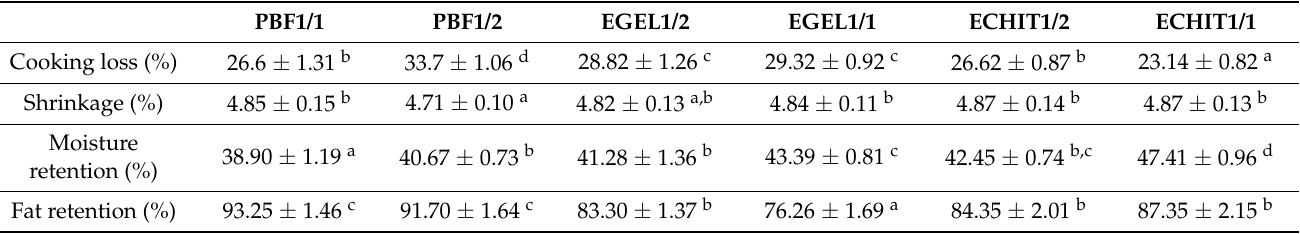
Table 5. Technological properties of control and reformulated pork patties